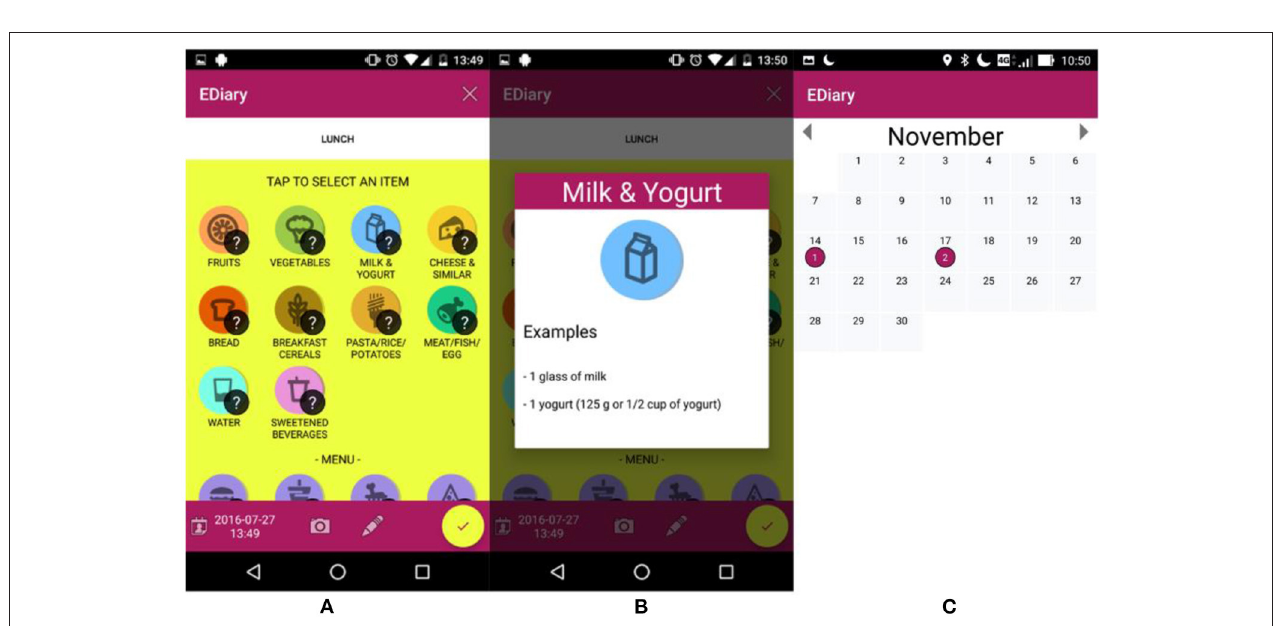
FIGURE 4 | e-Diary app interface: (A,B) show the selection of foods with the information to guide the selection of number of servings; (C) shows the interface to change the information of past meals.